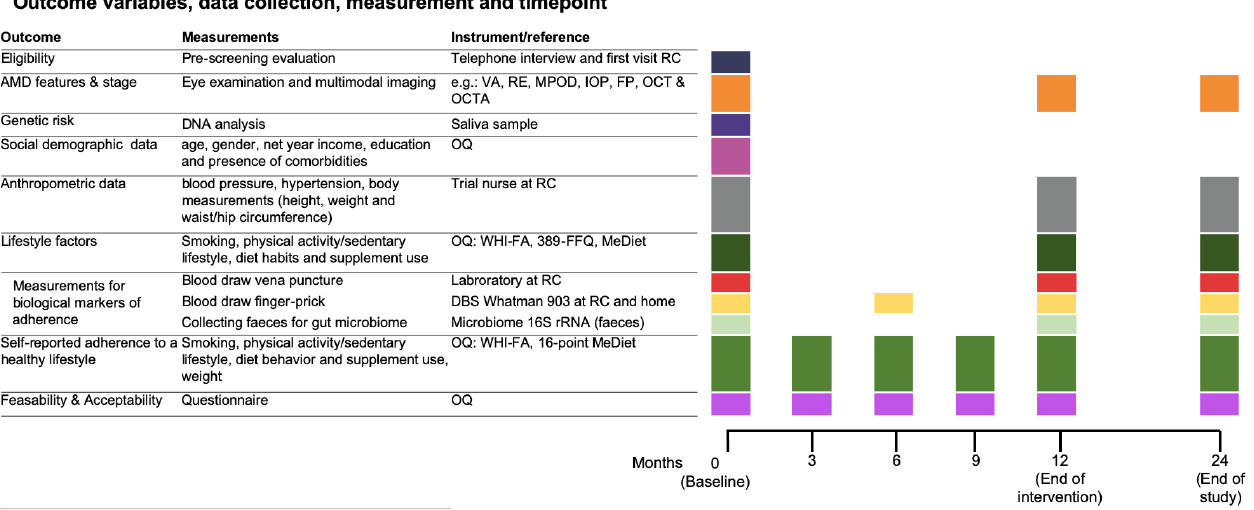
Figure 3. Data collection in AMD-Life. All study participants have the same measurements, irrespective of the study arm. Abbreviations: RC, research center; AMD, age-related macular degeneration; VA, best-corrected visual acuity; RE, refractive error; MPOD, Macular Pigment Optical Density; IOP, intra-ocular pressure; FP, fundus photography; OCT, optical coherence tomography; OQ, online questionnaire; WHI-FA, Women’s Health Initiative Physical Activity Questionnaire; 389-FFQ, food frequency questionnaire; MeDiet, Mediterranean Diet Score; BMI, body mass index; DBS, dried blood spot.